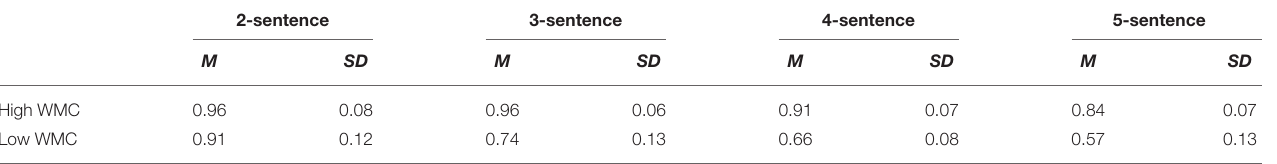
TABLE 2 | Mean word recall accuracy in each memory load condition for high and low WMC participants.